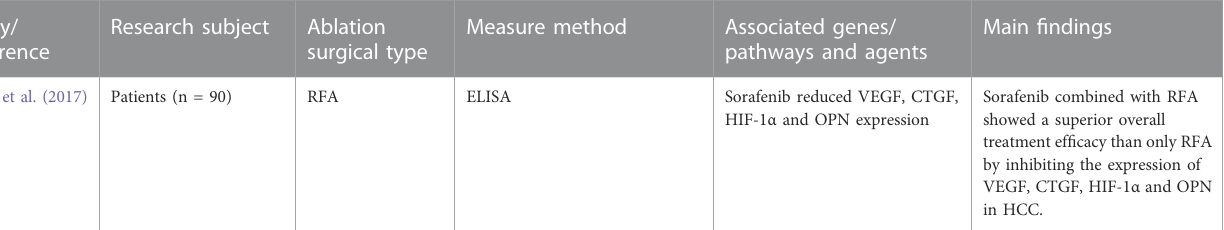
main stimulator of tumor angiogenesis and is reported to be overexpressed in multiple solid cancers, including HCC (Zou et al., 2020). Lin et al. (2018) demonstrated that long non-coding RNA UBE2CP3, a cancer-promoting gene of HCC, enhanced the progression of liver cancer by promoting angiogenesis through the activation of ERK1/2/HIF-1 α /VEGFA signaling pathway. A recent study conducted by Halpern et al. (2021) showed that a metastatic tumor model was established using a splenic injection of colon adenocarcinoma cells, and all mice undergoing RFA developed tumors at the ablation site on necropsy performed at 7 days. In contrast, the site of probe insertion had no tumors in the mice